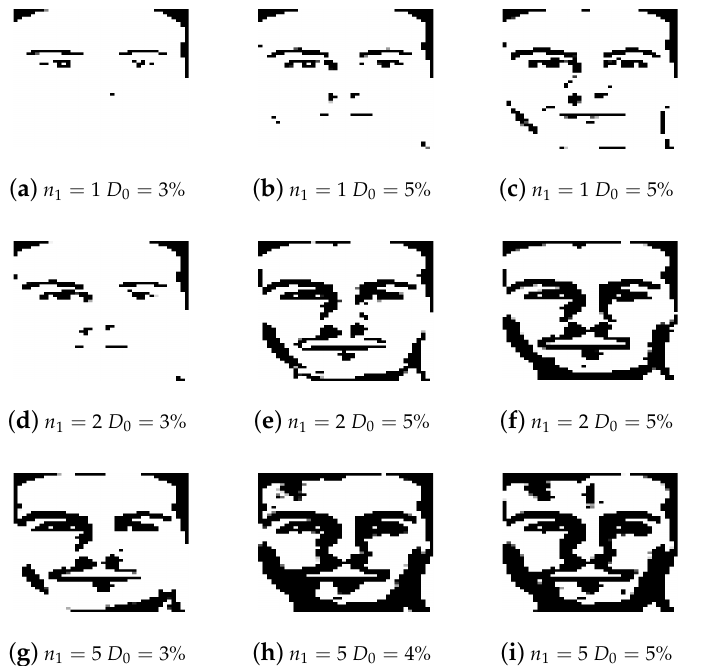
Figure 4. Figures from ( a – i ) present the change caused by the filter’s parameters, where n 1 is the order of the filter and D 0 denotes the cut-off frequency by the percentage of the image width. As can be seen, the features of the high-frequency texture components were related to the cut-off frequency, while the thickness of the texture depended on the order of the